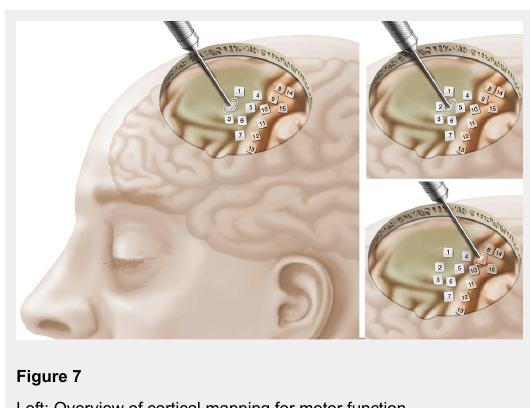
Left: Overview of cortical mapping for motor function. Top right: Intraoperative cortical mapping detects no motor function at sites labeled 1–7. Bottom right: Motor function of the hand is detected and spared during surgery at site labeled 8 (further motor function sites detected and spared at sites